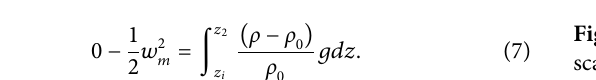
Figure 9A , the experimental results give the following quanti fi ed scaling relation: